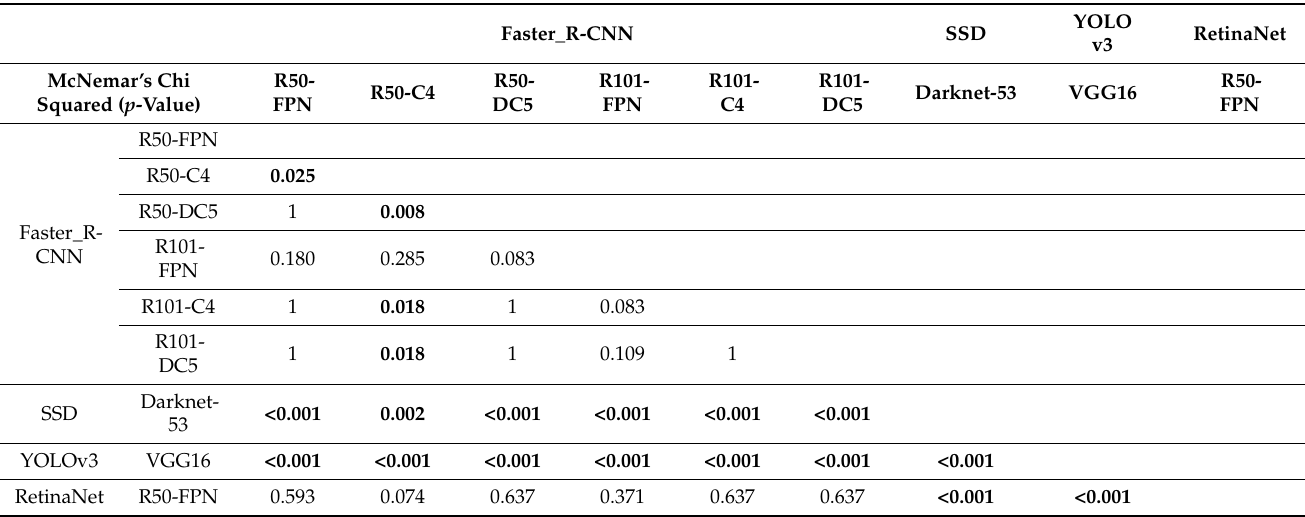
Table 4. p -value of McNemar’s Test for comparing different deep learning model performances. p -values under 0.05 indicate the two compared models are significantly different. (The bold font indicates models that were statistically different).